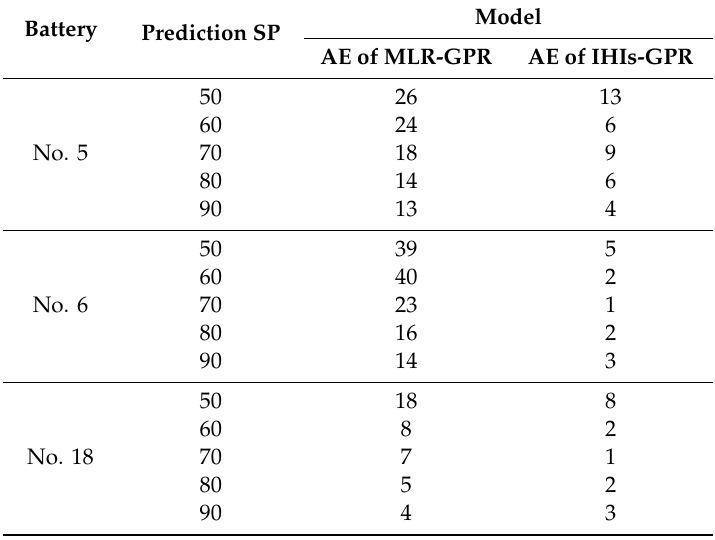
Table 6. Comparison of di ff erent RUL prediction models for three